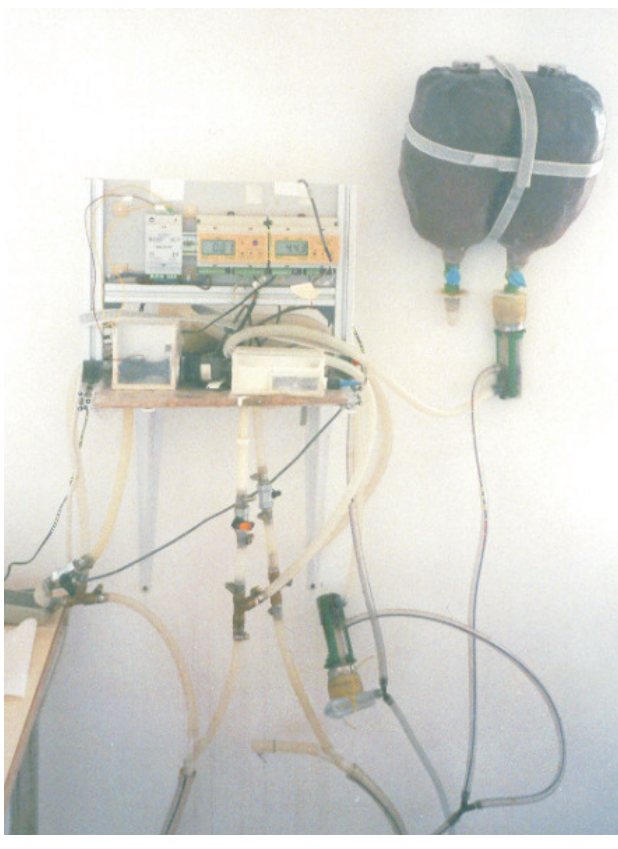
Figure 4. On-line testbed for evaluation of probes.